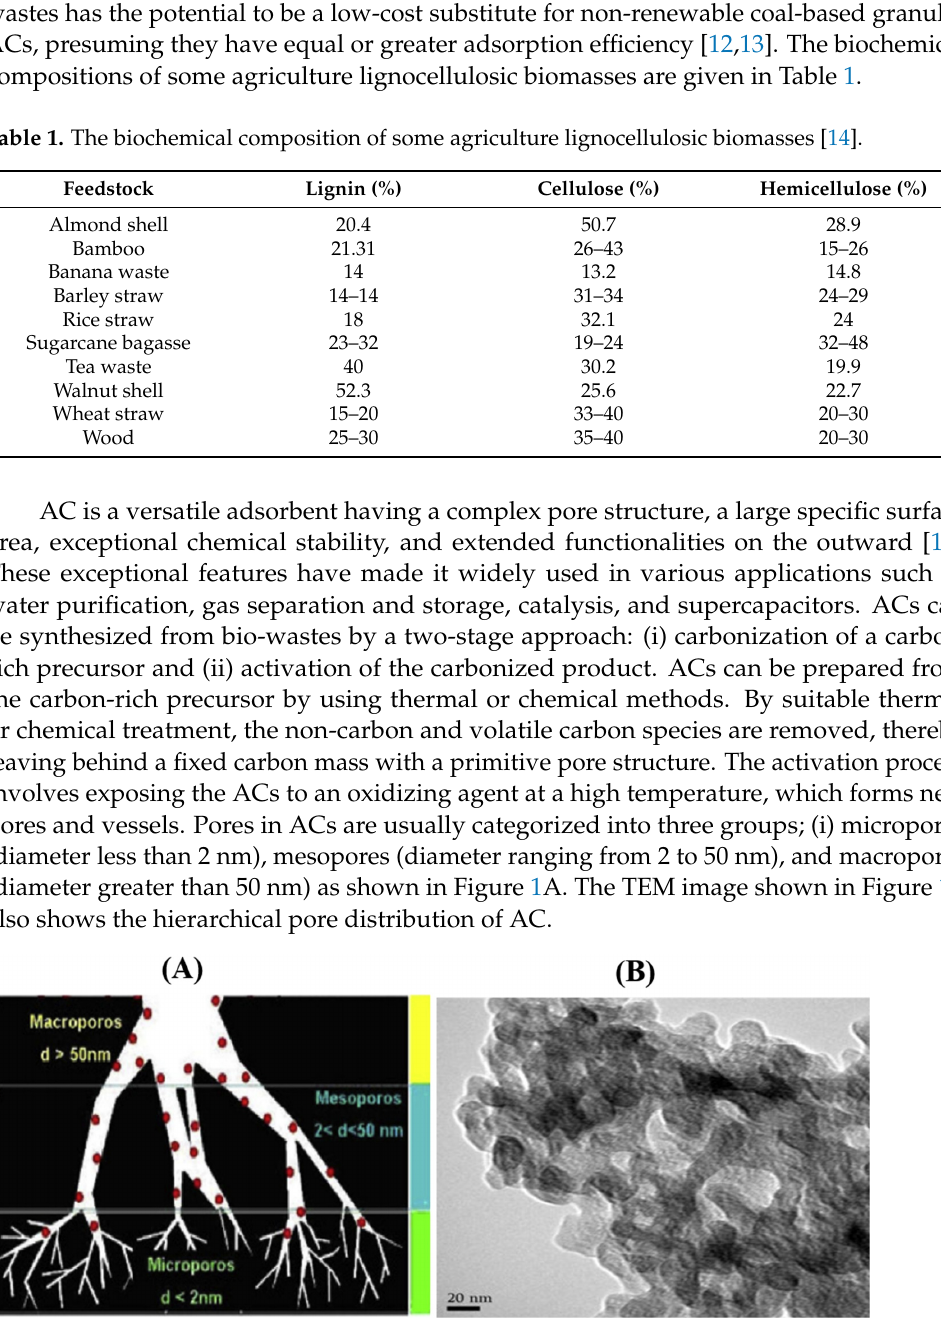
Figure 1. ( A ) Schematic diagram representing the three types of pores for pollutant adsorption [16] . Reprinted with per- mission from the Journal of Analytical and Applied Pyrolysis , Copyright Elsevier 2021. ( B ) TEM image of AC showing